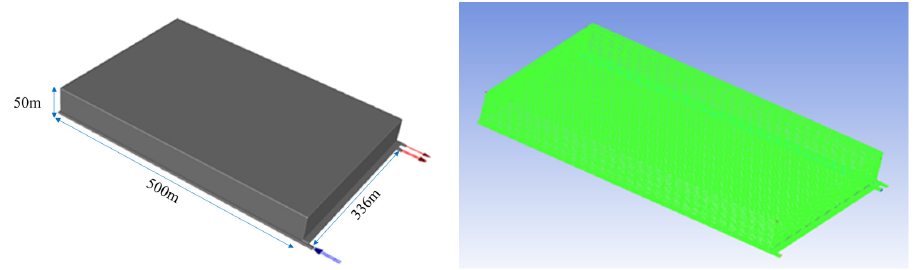
Figure 3. The 3D model and grids of gob in working face (own elaboration).